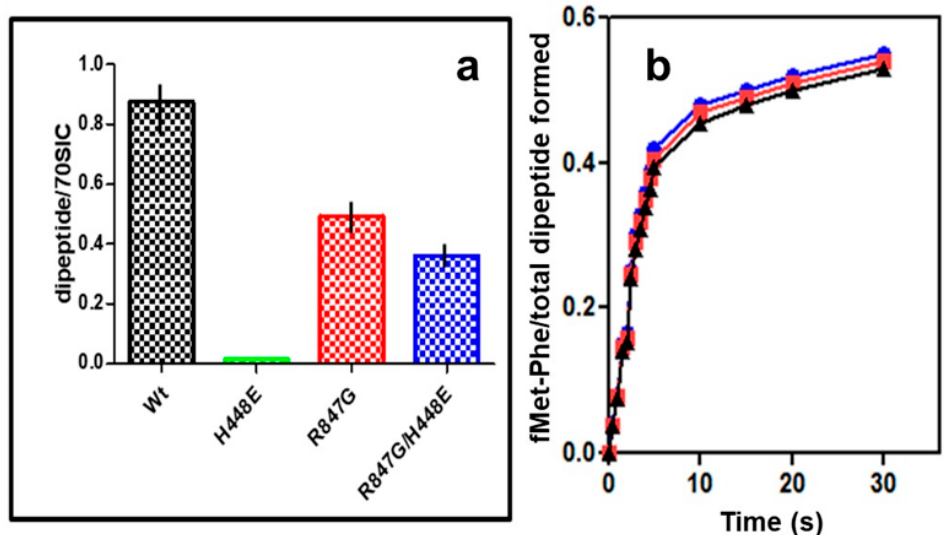
Figure 7. Initiation dipeptide formation in the presence of IF2 wt and IF2 mutants. The f[ 3 H]Met-[ 14 C]Phe initiation dipeptide was formed by mixing and incubating equal volumes of EF-Tu • GTP • [ 14 C]Phe-tRNA ternary complex and 70S IC formed in the presence of IF2 wt (black), IF2 R847G (red), IF2 H448E/R847G (blue), and IF2 H448E (green) and f[ 3 H]Met-tRNA. The experimental details are given in Materials and methods. ( a ) The level of dipeptide formed in the presence of IF2 wt or IF2 mutants after 20 min incubation at 37 ◦ C is expressed as the ratio of dipeptide formed vs. amount of initiator fMet-tRNA present in the corresponding 70S IC; ( b ) kinetics of initiation dipeptides formation by 70S IC complexes formed in the presence of IF2 wt or IF2 mutants. No dipeptide was formed in the absence of